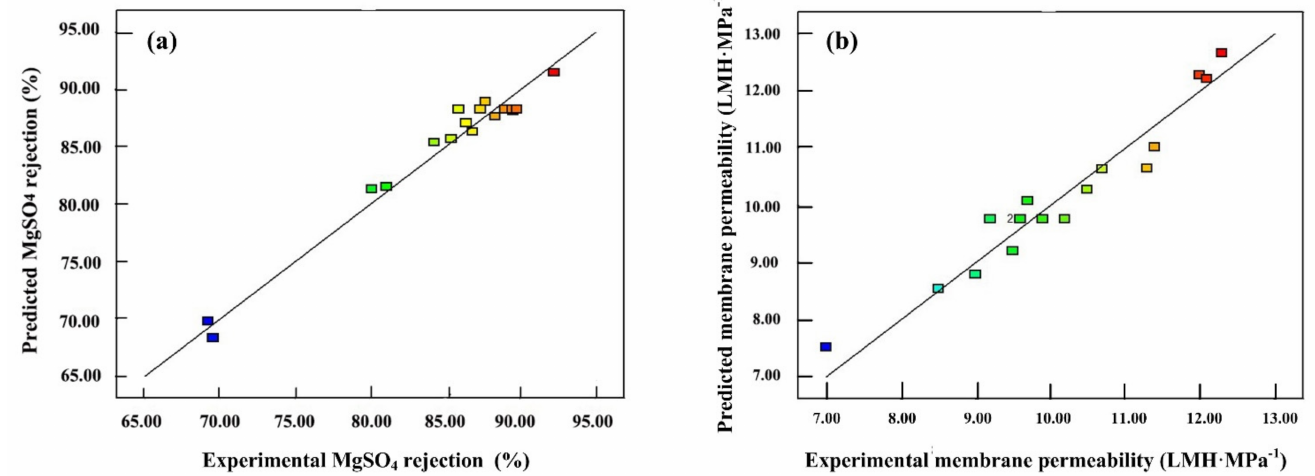
Figure 4. Predicted MgSO 4 rejection rate ( a ) and membrane permeability ( b ) versus their correspond- ing experimental